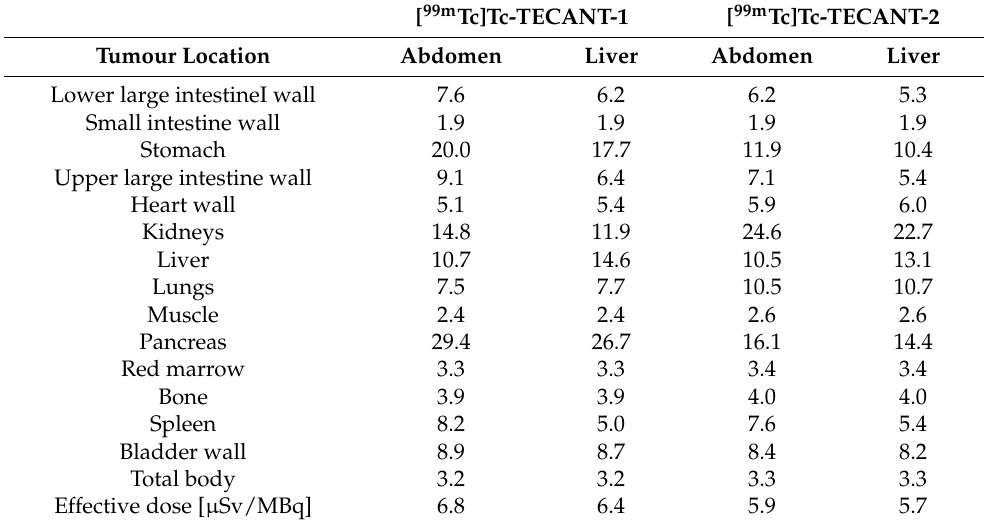
Table 3. Dose to various organs, average total body dose ( µ Gy/MBq) and effective dose ( µ Sv/MBq) for both radiotracers and two possible locations of the tumour (abdomen,